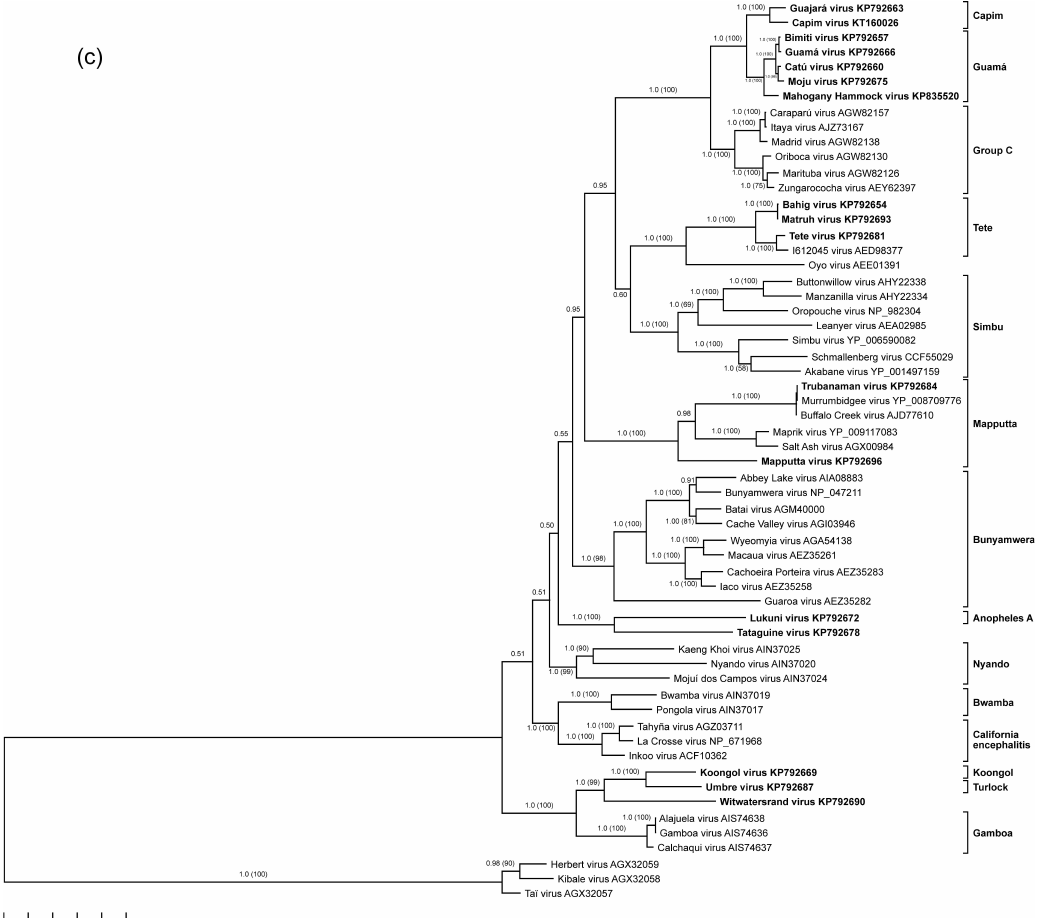
Figure 1. Protein sequence-based phylogenies of orthobunyaviruses. Phylogenies were inferred for ( a ) N; ( b ) glycoprotein precursor polyprotein; and ( c ) L proteins using Bayesian and Maximum Likelihood analyses. The LG + I + G model of amino acid (aa) substitution was used for inferring the N protein phylogeny, whereas the LG + I + G + F model was used to investigate glycoprotein precursor polyprotein and L protein phylogenetic relationships. Numbers represent Bayesian posterior probabilities (Maximum Likelihood bootstrap values). “Herbeviruses” (Herbert virus, Kibale virus, and Taï virus) [5,6] were used to root the phylograms. Trees are drawn to scale measured in substitutions per site. In (a), viruses that encode NSs proteins are marked in blue, whereas viruses that do not are marked in red. Viruses studied in the present work are depicted in bold. GenBank accession numbers and serogroups are to the right of virus